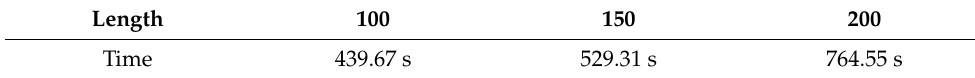
Figure 7. The results of model detection effects with different input lengths. Table 8. The time required for the model with different lengths of the